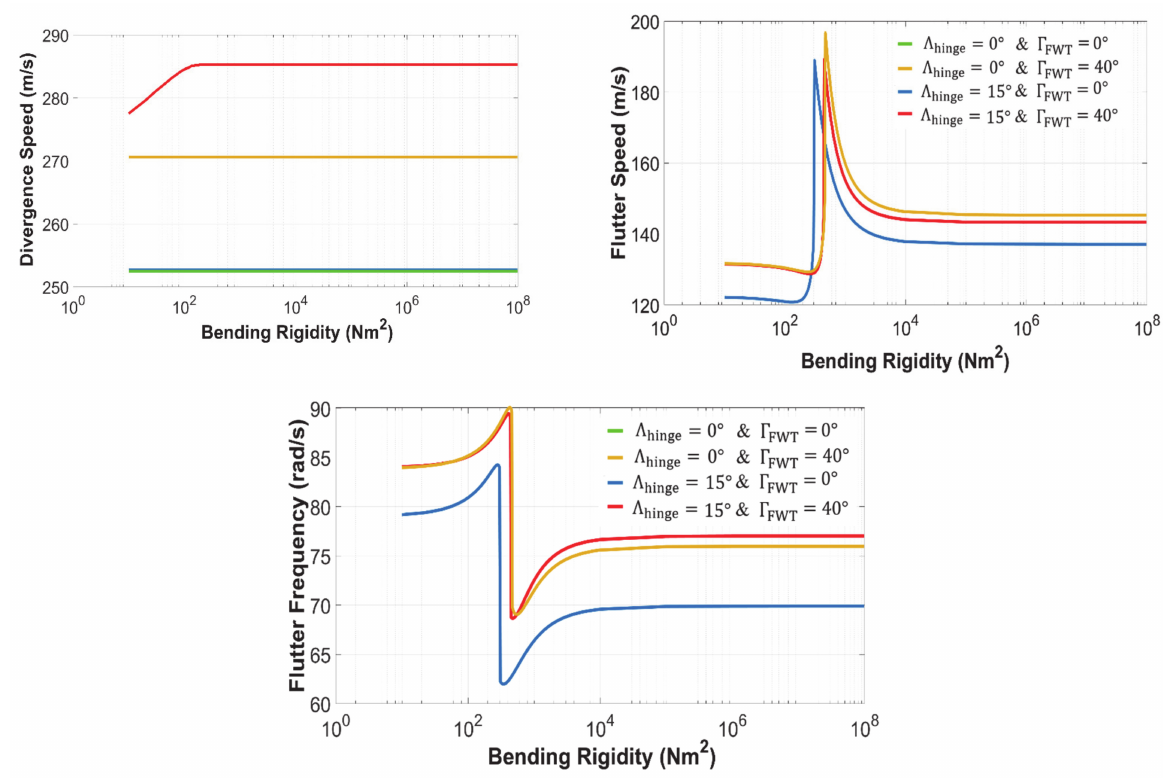
Figure 9. Variations with bending rigidity of the hinge for a tip length of 1.016